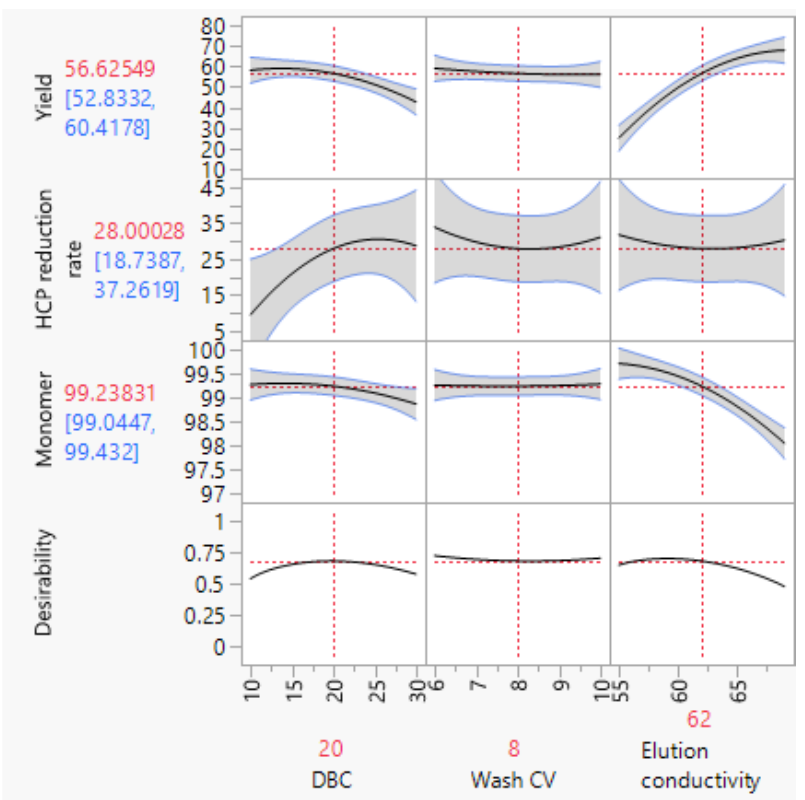
Figure 6. Prediction profiler depiction changes in Fc-fusion protein yield and purity as a function of the factors studied in a CCF DoE